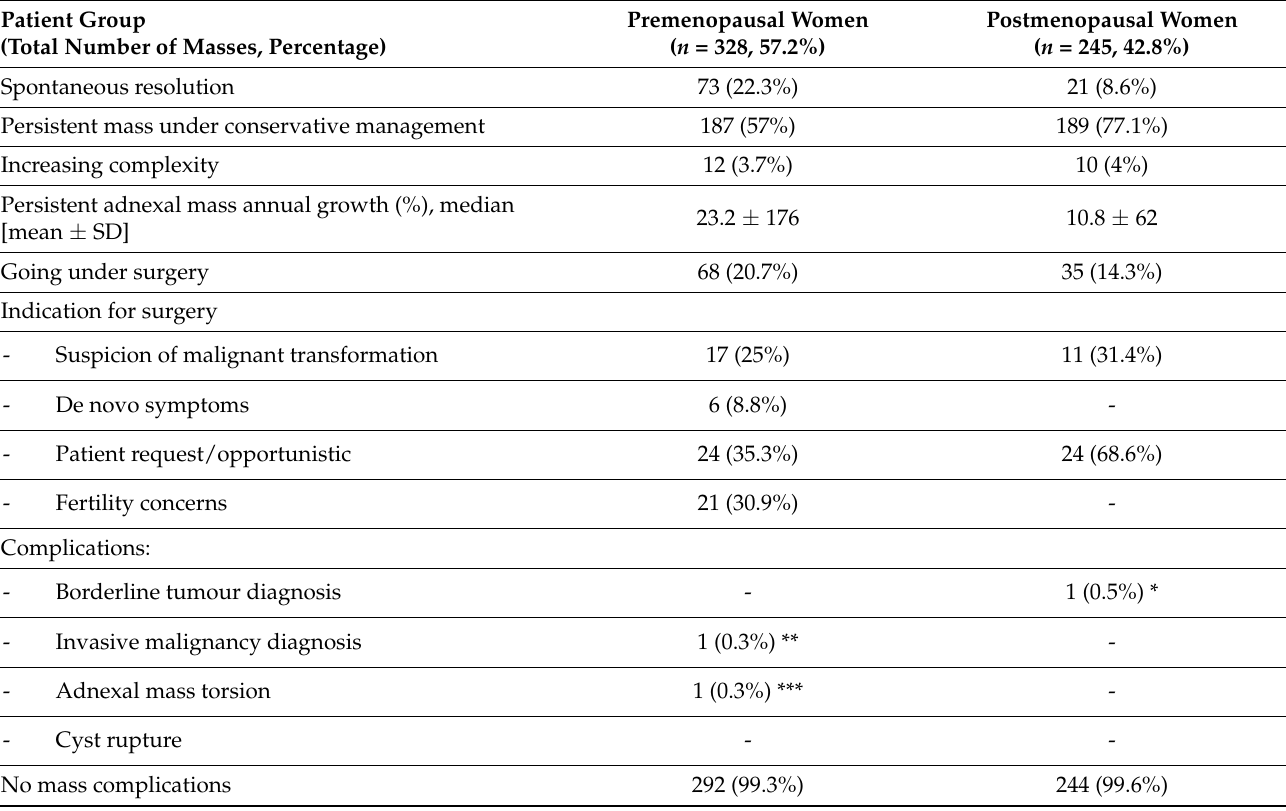
Table 3. Patient ultrasound and clinical evolution (summary of the study’s main outcomes).